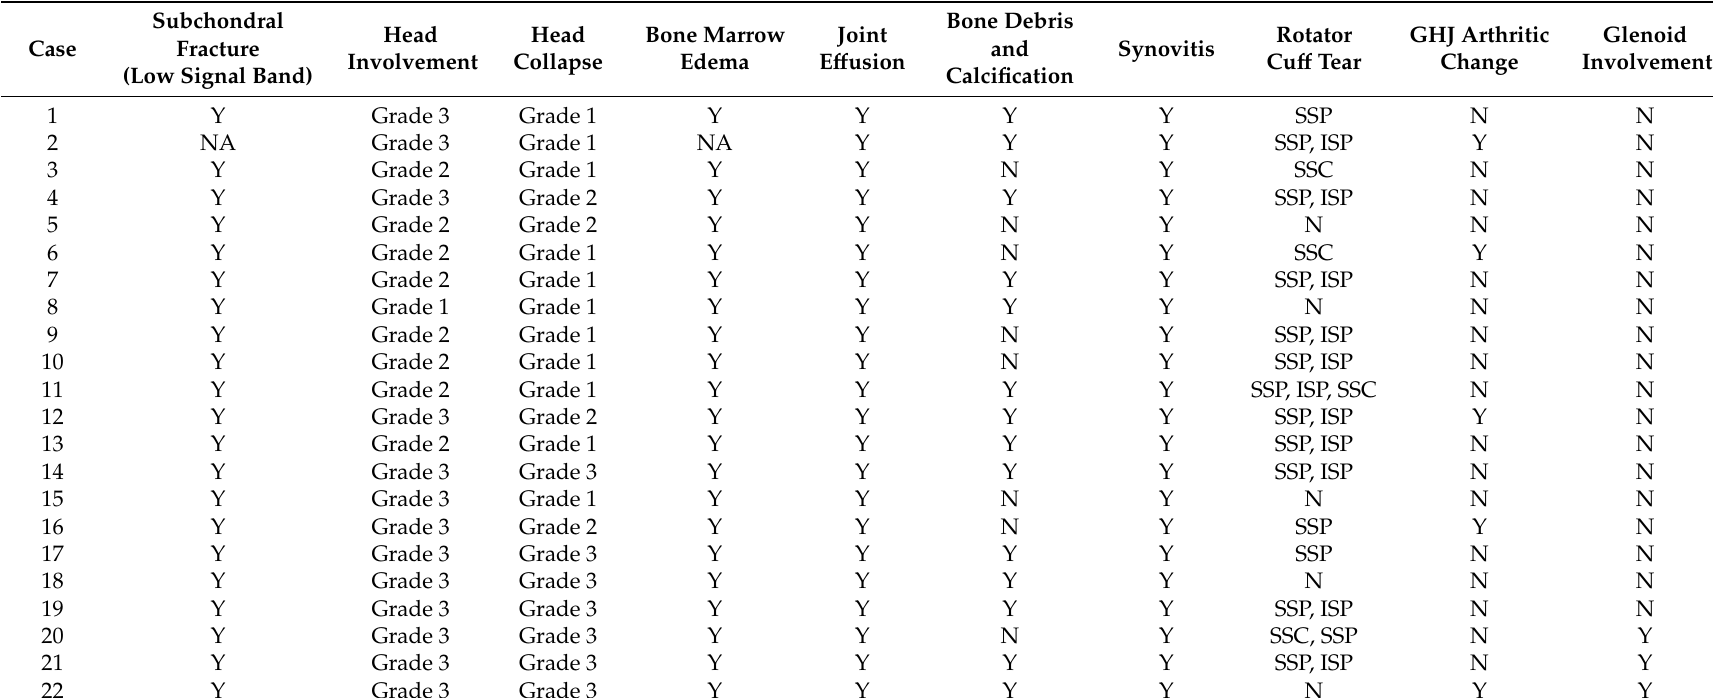
Table 2. Radiographic findings based on plain radiographs, computed tomography, and magnetic resonance